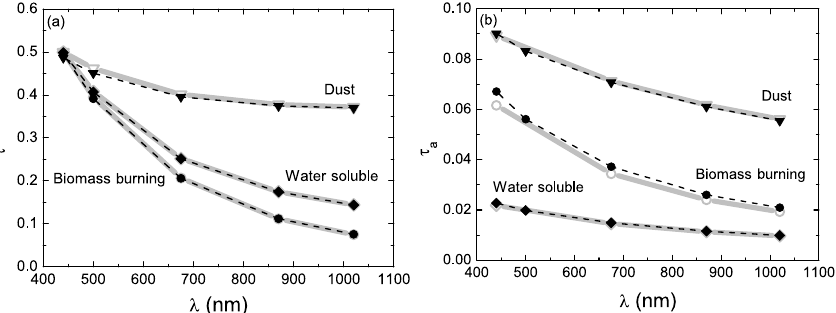
Figure 4. Recovery of spectral τ (left) and τ a (right) for three aerosol types (thick line: true; thin line: recovered, corresponding to the separated sub-mode CRIs in Fig.